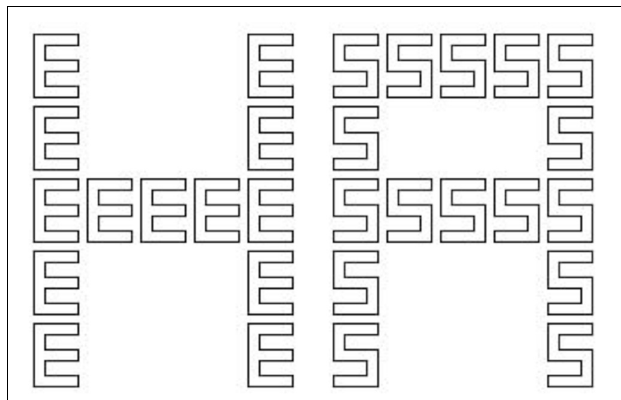
FIGURE 1 | Two examples of the hierarchical letters presented in the experiment. Both stimuli are incongruent. In the experiment the stimuli were presented in white on a black